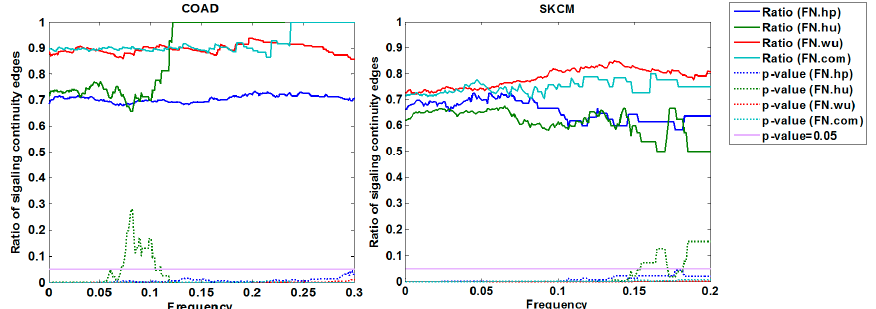
Figure 3. Functional continuity of identified fitness relationships cross-validated by a signaling network. Driver genes in FNs are mapped into an independently collected signaling network.